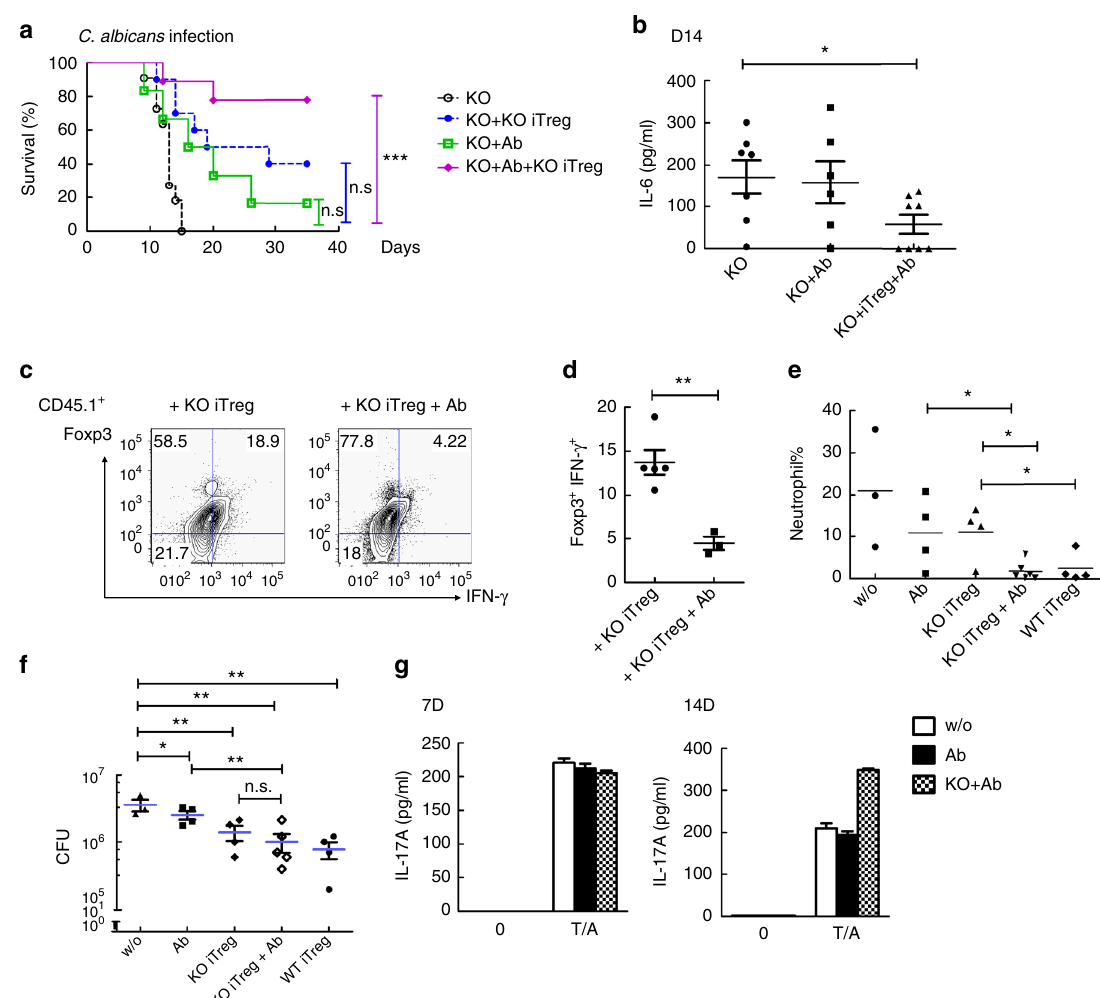
Fig. 8 Combination anti-IL-6R and Xiap − / − Treg cells rescue mice from infection-induced in fl ammation. a , b Xiap − / − iTreg cells plus anti-IL-6R rescue Xiap − / − mice from C. albicans infection. Male Xiap − / − mice (KO) were intravenously administered with C. albicans and Xiap − / − iTreg cells (1 × 10 6 ) or anti-IL- 6R antibody (500 μ g) at day 2, or both, as indicated. Survival of mice is presented as a Kaplan – Meier survival curve ( a ). n = 11 for KO, n = 10 for KO + KO iTreg, n = 6 for KO + Ab, n = 9 for KO + KO iTreg + Ab. *** P < 0.001 for Log-rank (Mantel – Cox) Test ( a ). n.s., not signi fi cant. The serum level of IL-6 was determined on day 14 after infection ( b ). * P < 0.05 for unpaired t -test ( b ). c , d Anti-IL-6R prevents the conversion of the transferred Xiap − / − Treg cells. CD45.1 + Xiap − / − iTreg cells were transferred into CD45.2 + Xiap − / − mice infected with C. albicans as in ( a ). CD45.1 + T cells were recovered at day 10 post- infection, and the expression of Foxp3 and IFN- γ was determined ( c ). The Foxp3 + IFN- γ + fractions in the CD45.1 + Treg cells were quantitated ( d ), n = 5. ** P < 0.01 for unpaired t -test ( d ). e , f Anti-IL-6R reduces kidney neutrophil in fi ltration and fungal load in C. albicans -infected Xiap − / − mice with KO iTreg cells transfer. Male Xiap − / − mice were infected with C. albicans , as described in ( a ). Kidneys were isolated 14 days post-infection and neutrophils ( e ) and C. albicans titres ( f ) were quantitated. * P < 0.05, ** P < 0.01 for unpaired t -test. n.s., not signi fi cant. g Anti-IL-6R does not affect IL-17 production. Male CD45.1 + Xiap − / − mice were infected with C. albicans and treated with anti-IL-6R and anti-IL-6R plus CD45.2 + KO iTreg cells. Spleen T cells and B cells were isolated 7 days after treatments. CD45.2 + iTreg cells were depleted. T cells were incubated with B cells and heat-killed C. albicans (HKCA) for 4 days, and the production of IL-17A after stimulation with TPA/A23187 (10/100ng ml − 1 ) was determined by ELISA 47, 48 . Values are mean ± SD of triplicate samples in an experiment. Experiments were independently repeated three times with similar